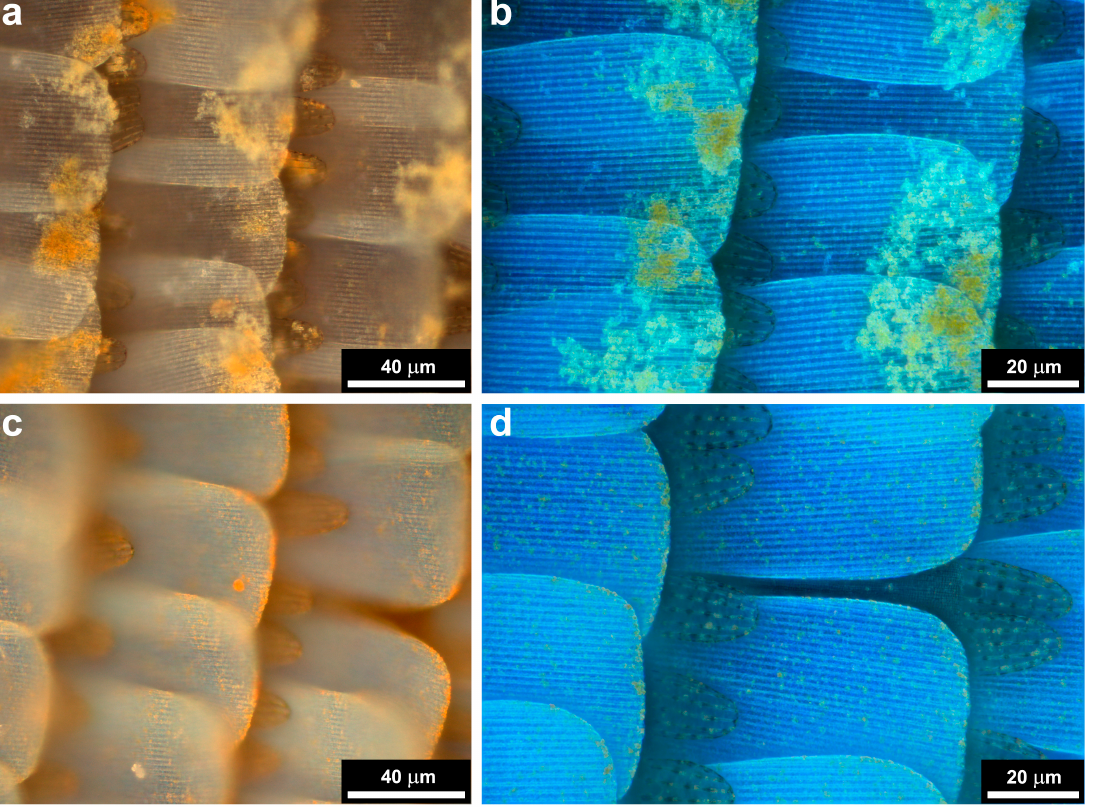
Figure 8. Optical and SEM micrographs of type-1 and type-2 samples after the application of 120 µL of Cu 2 O sol. ( a ) Type-1 sample, optical microscope image recorded with crossed polarizers; ( b ) type- 1 sample image recorded on a focus stacking optical microscope using partially crossed polarizers; ( c ) type-2 sample, optical microscope image recorded with crossed polarizers; ( d ) type-2 sample image recorded on a focus stacking optical microscope using partially crossed polarizers; ( e ) SEM micrograph of a type-1 sample; ( f ) SEM micrograph of a sample type-2; ( g ) detail of image in ( e ), note the clustering between the ridges; ( h ) detail of the image in ( f ), note the individual nanoparti- cles between the ridges marked by arrows. In Figure 9, the digital photographs of the wing region seen through the circular opening of the PTFE frame are shown for type-1 and type-2 samples before the first